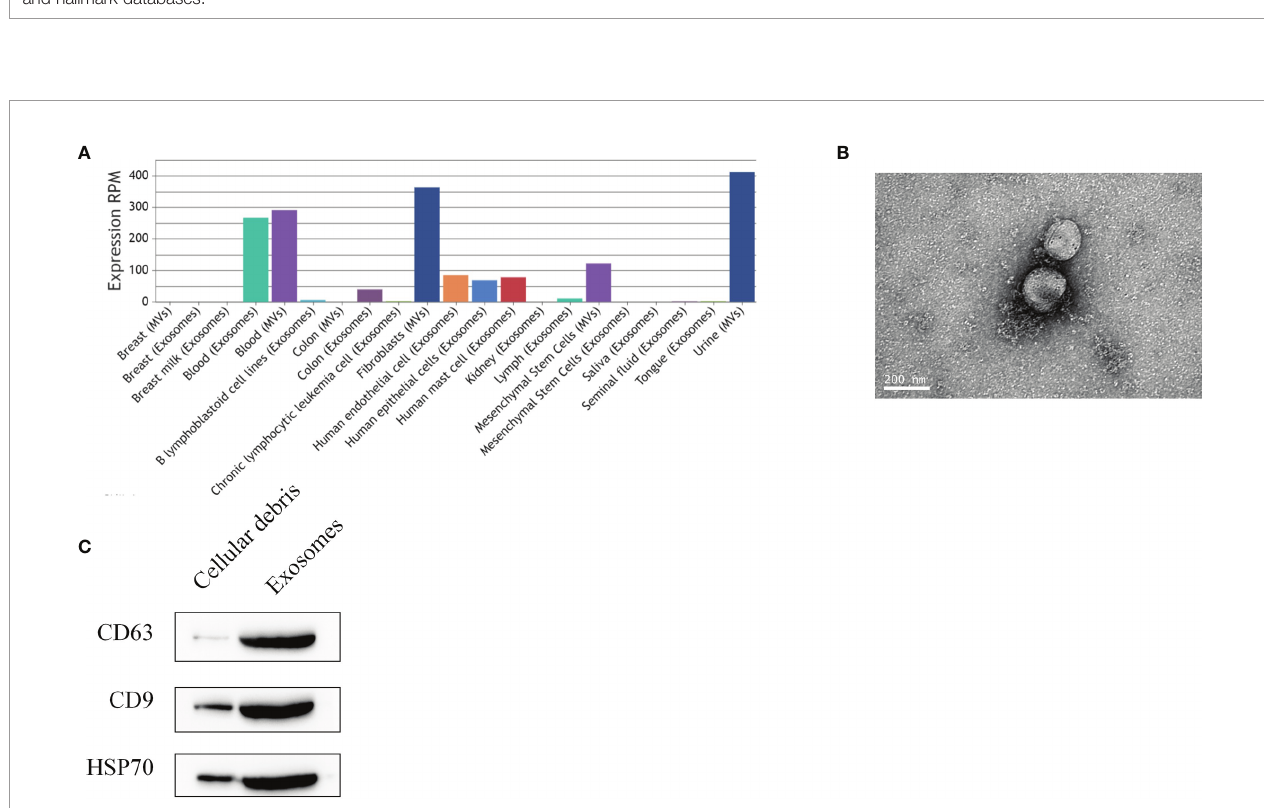
FIGURE 6 | Enrichment analysis of FBN2, MEX3A, and TPD52 in KEGG and hallmark datasets. (A) Top three most relevant pathways of FBN2 in KEGG and hallmark databases; (B) Top three most relevant pathways of MEX3A in KEGG and hallmark databases; (C) Top three most relevant pathways of TPD52 in KEGG and hallmark databases.